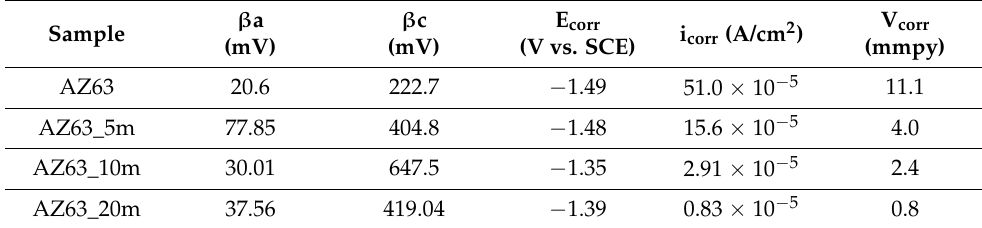
Table 8. Calculated corrosion